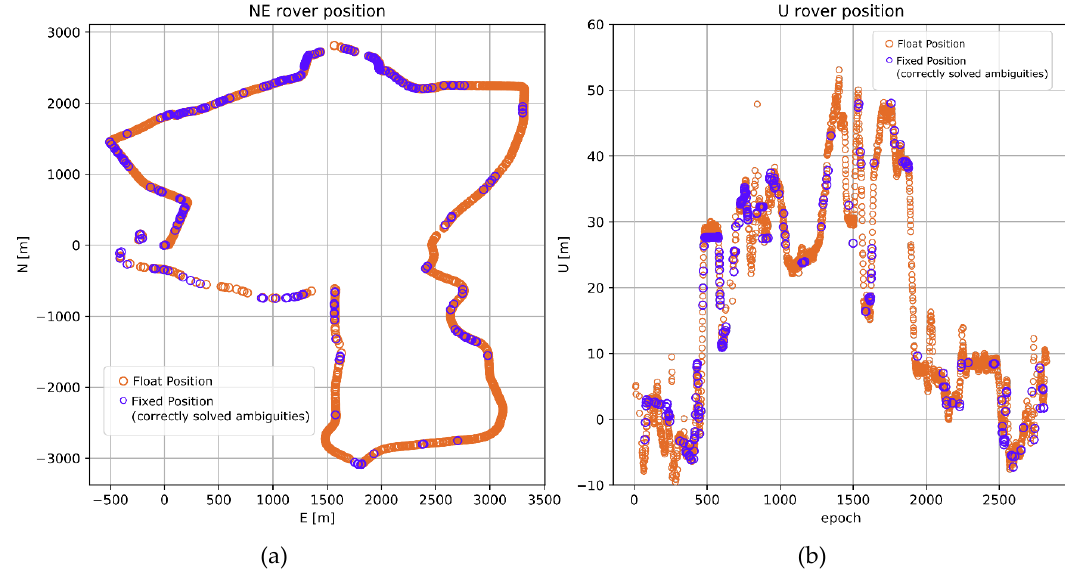
Figure 5. Rover trajectory from processing 82 km baseline (BROD), no ionospheric corrections. ( a ) Horizontal components; ( b ) Vertical components.